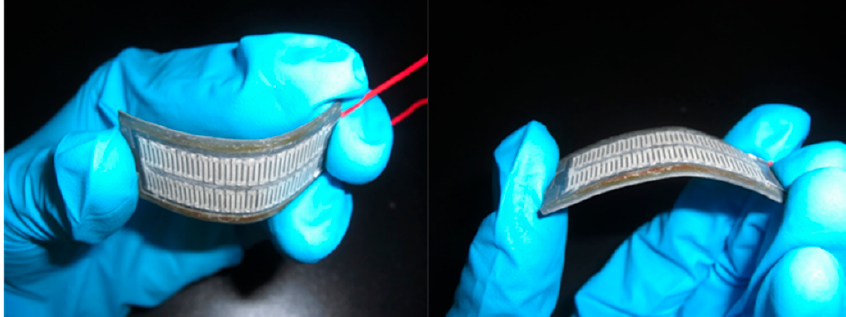
Figure 7. Demonstration of the flexibility of the flexible thermoelectric generator.